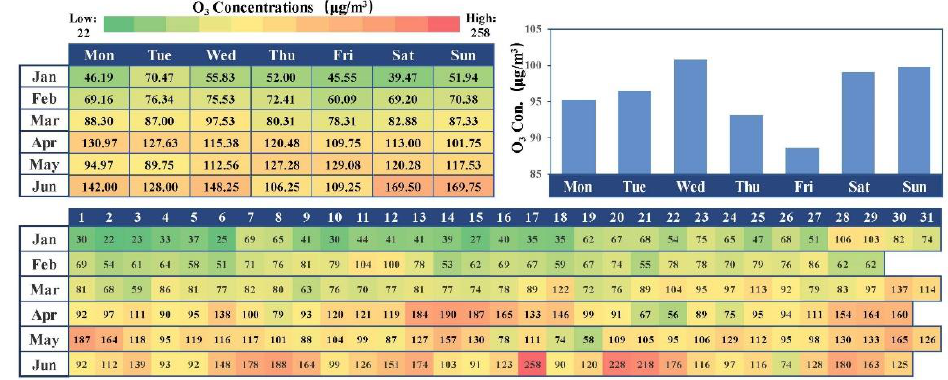
Figure 4. Status of daily average O 3 concentration and weekly statistics in the first half of 2020.